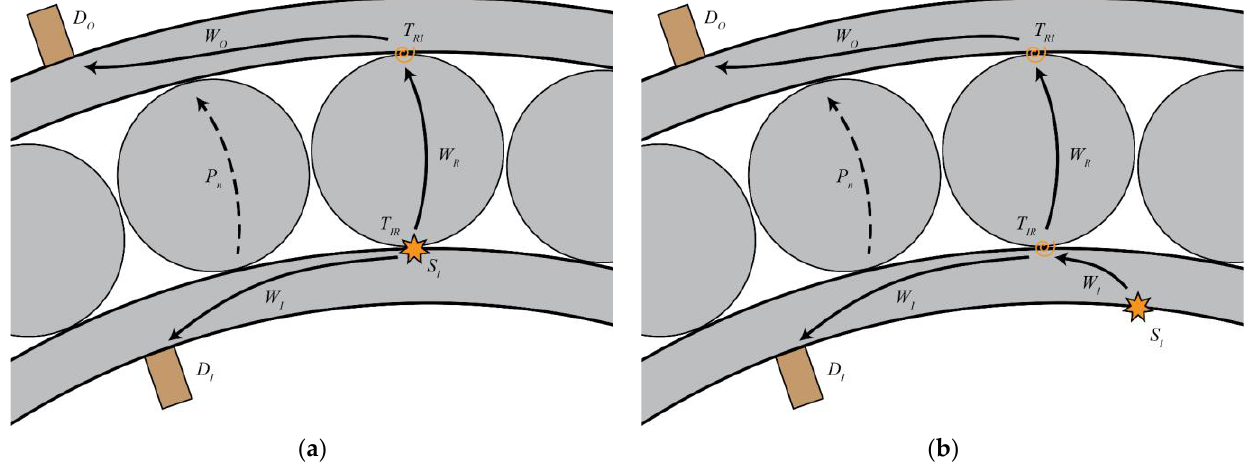
Figure 1. Representation of the wave propagation paths, showing: ( a ) the propagation paths associated with a natural sub-surface defect originating on the inner raceway, and ( b ) the propagation paths as simulated in the experiment. In both, the primary path is represented by a continuous line, and an alternative path as a dashed line.